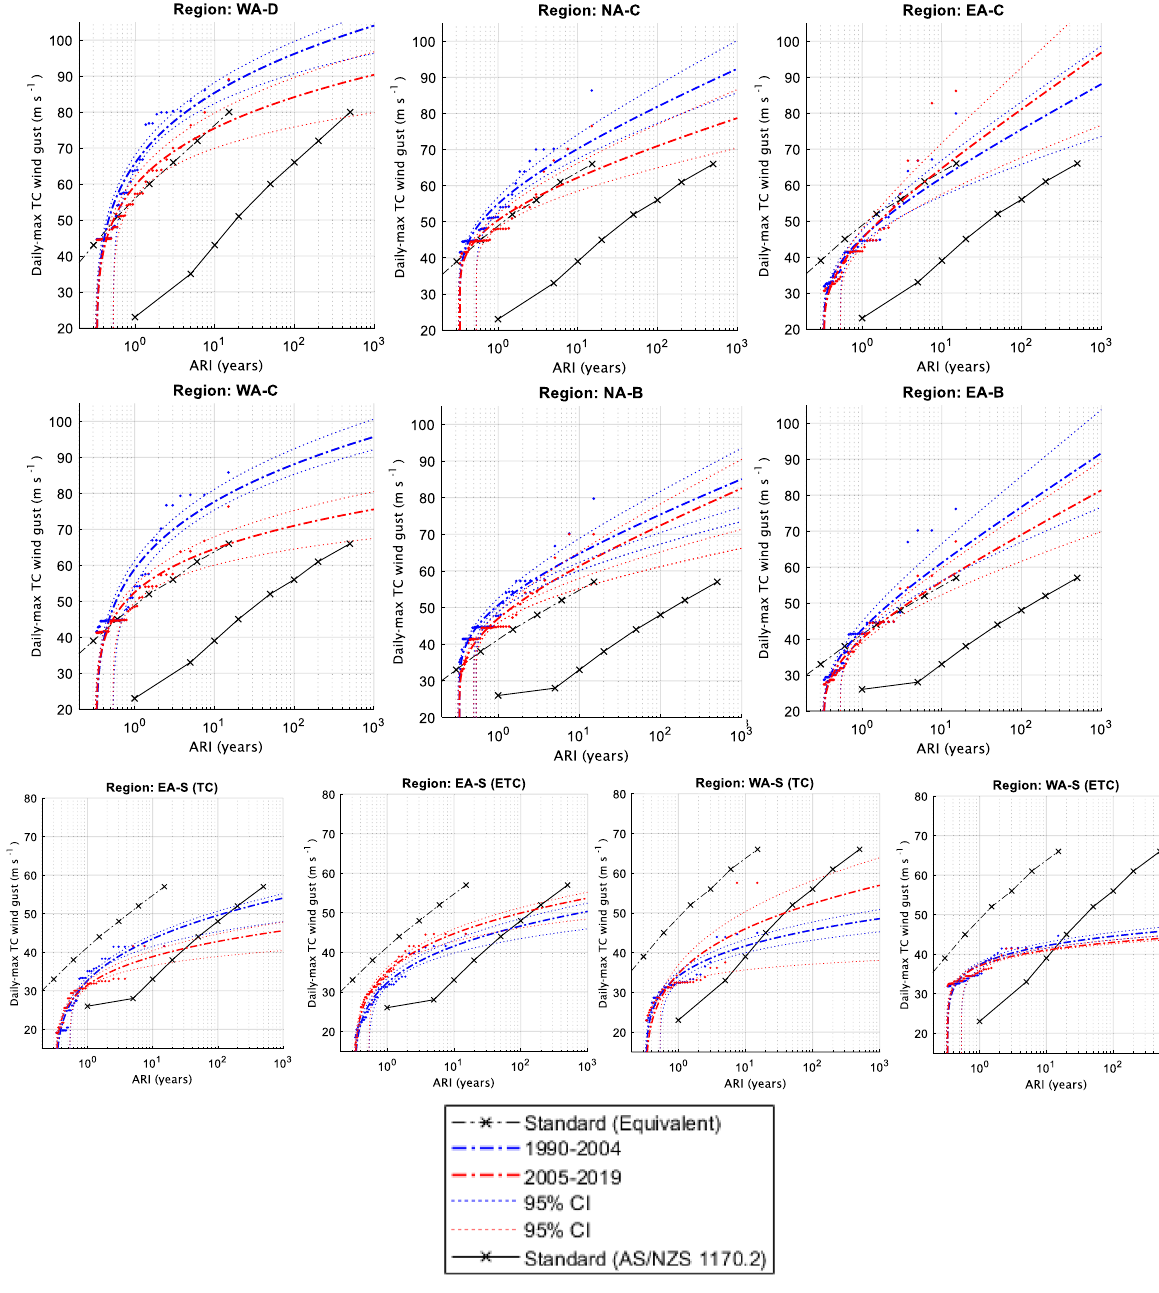
Figure 6. Average recurrence intervals (ARIs) of TC-related daily maximum wind gusts (0.2 s) for the calibrated BARRA